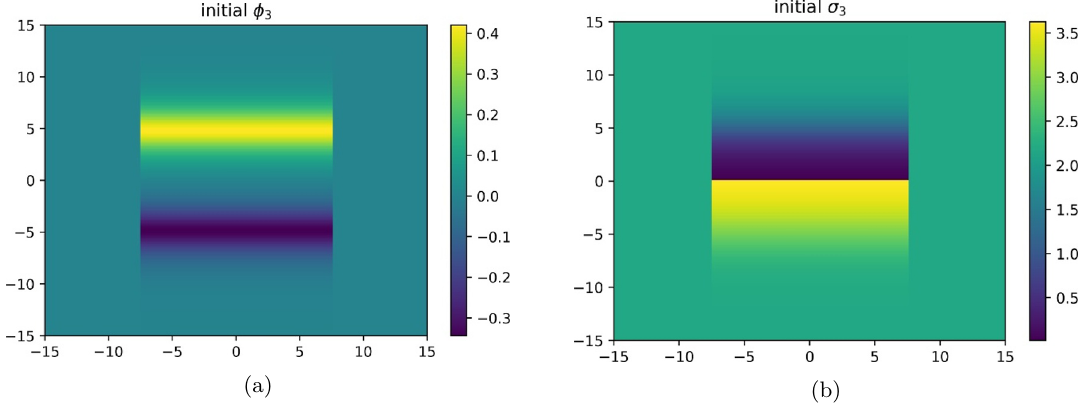
Figure 3. A typical example of the BPS initial configuration. The parameters are: N = 5 , weight w 2 , and quark separation R = 15 . The grid size is 30 by 30 in units of the dual photon mass. Note that there are N − 1 = 4 field components, each with real and imaginary parts. Only the (a) real and (b) imaginary parts of the third field are shown, though the rest are similar. Outside of the quarks, the field is set equal to the boundary value, i 2 π ρ . In between the quarks are many copies of pairs N of BPS DWs, interpolating from the boundary value to 0 and from i 2 π w 2 back to the boundary value. The field discontinuity has a value that matches the monodromy and its location and shape match the Dirac delta function in the 2D EOM (5.1). We have used Kähler metric without quantum correction. Using the Gauss-Seidel iterations, this initial configuration relaxes to figure